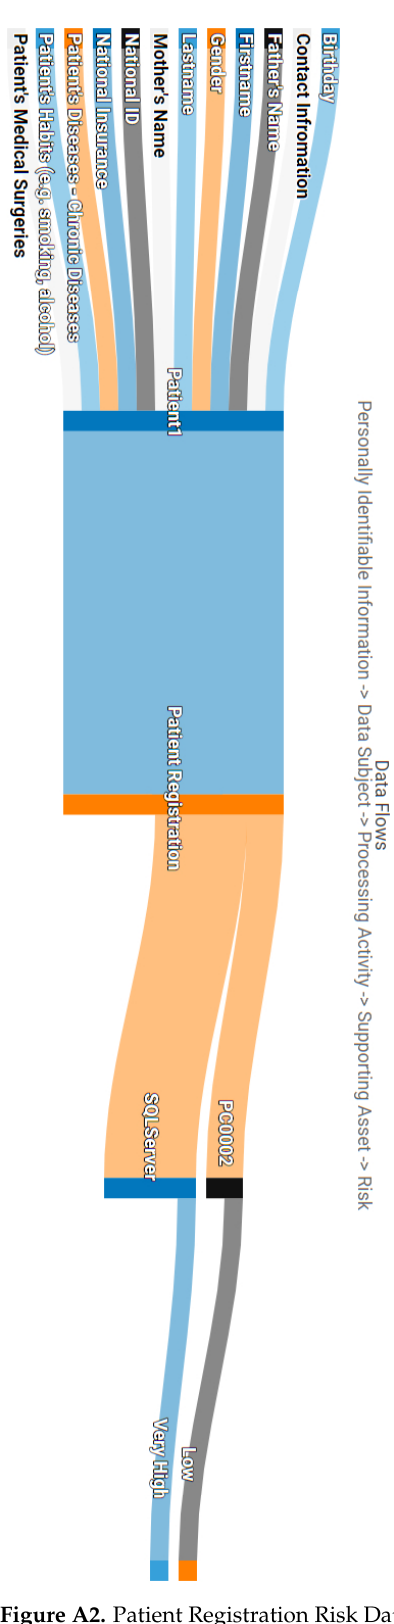
Figure A2. Patient Registration Risk Data